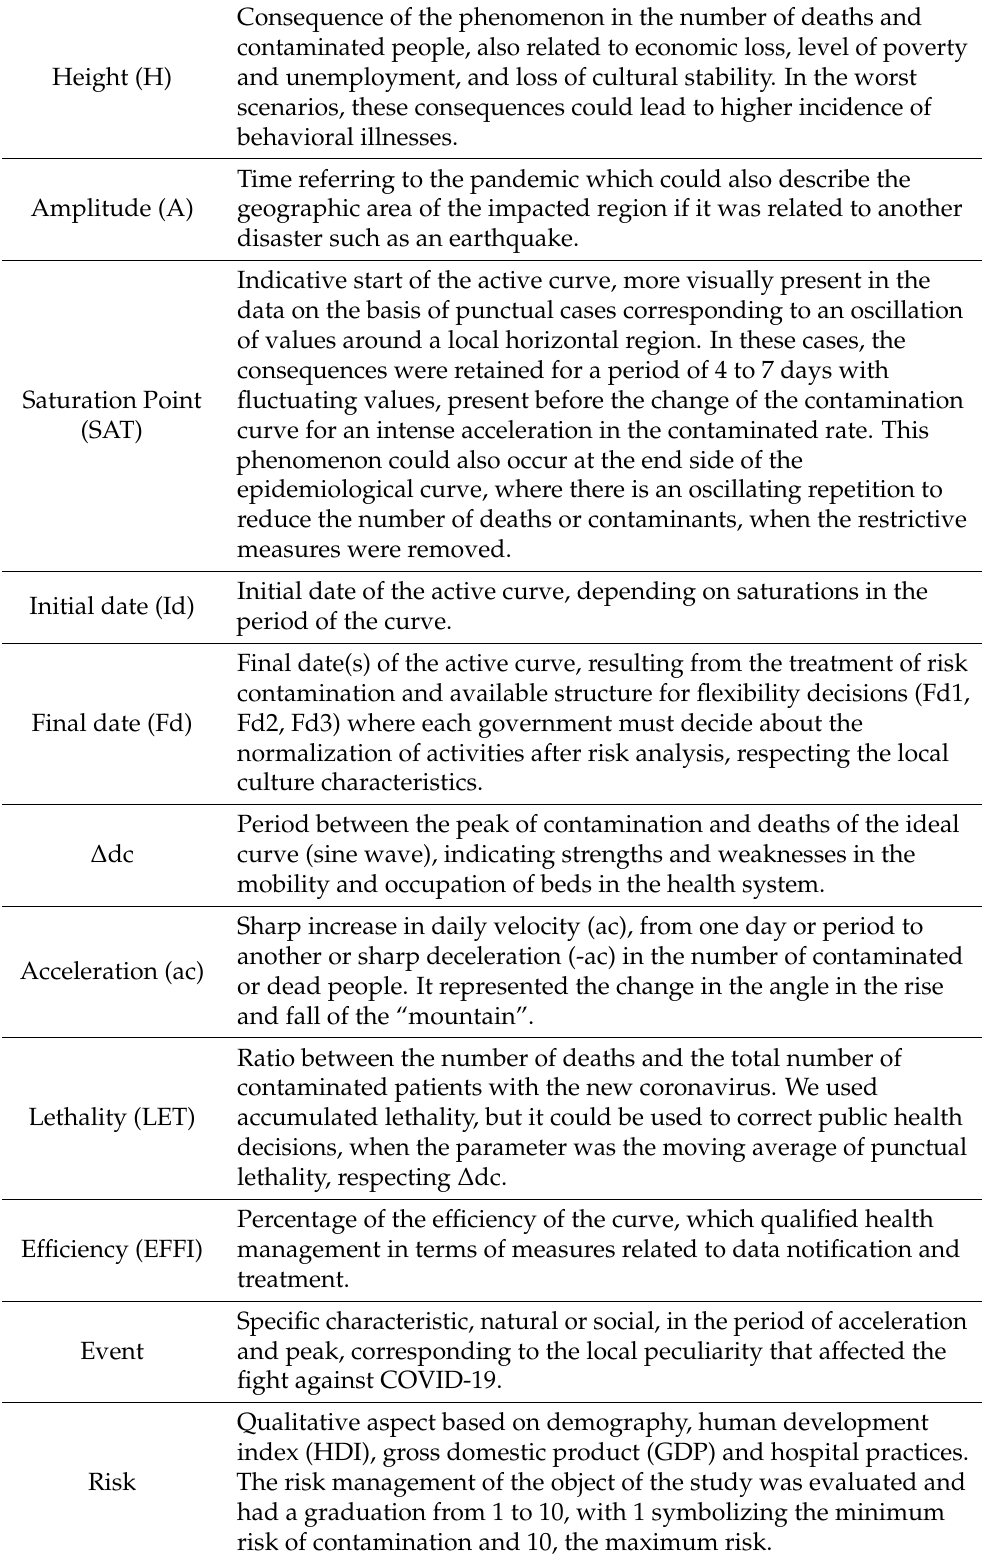
Table 2. Parameters and respective